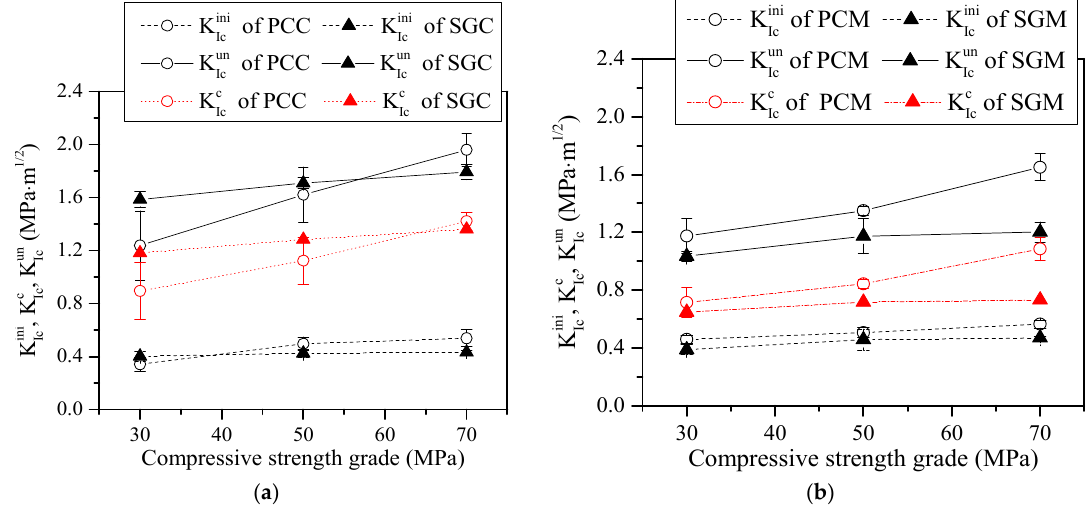
ini K , c K , and un K of ( a ) PC and SG concrete and ( b ) PC and SG mortar. Figure 5. The K ini , K c , and K un of ( a ) PC and SG concrete and ( b ) PC and SG Ic Ic Ic Ic Ic Ic